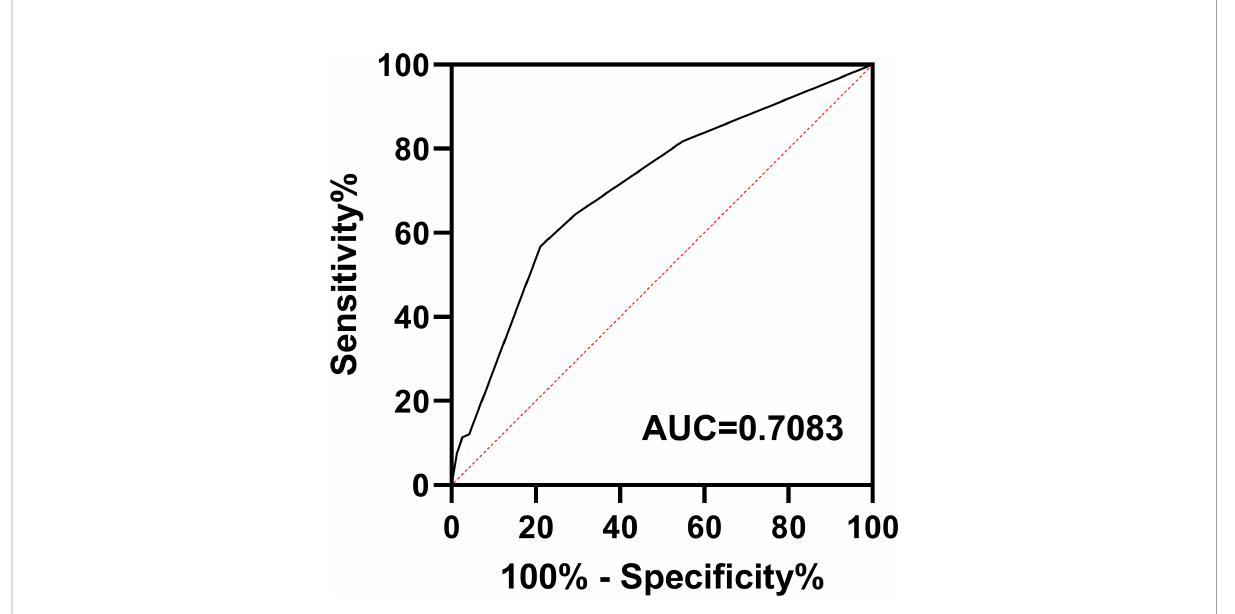
FIGURE 3 Receiver operating characteristic curve for the pneumonia prediction model. AUC, area under the